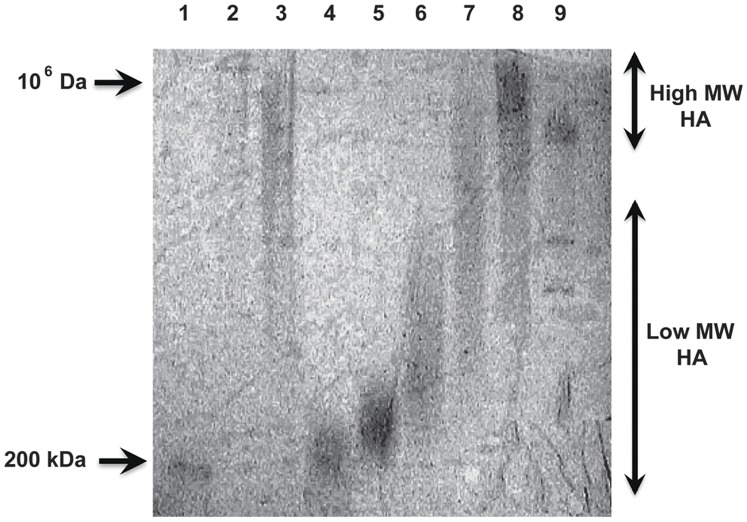
Fragmentation of HA by peroxynitrite and stimulation of TNFα and IL1ß by oligomeric HA in vitro.HMW HA (Healon™, 1×106 Da, Lane 2) was exposed to 100 µM 3-morpholinosydnonimine (SIN-1), a compound that spontaneously releases NO and superoxide to generate peroxynitrite. Exposure of HMW HA to SIN-1 results in degradation to LMW HA (300–500 kDa, Lane 6). Exposure to SIN-1 in the presence of 600 mU/ml superoxide dismutase (SOD) partially protects this degradation (Lane 7). Exposure to 300 µM PAPANOATE, a pure NO donor, does not degrade Healon™ (Lane 8). In addition, treatment of Healon™ with either 1 U/ml Streptomyces hyaluronidase at 60°C for 2 hours (Lane 4) or sonication for 2 minutes (Lane 5) results in formation of LMW HA. Just heating HMW HA at 60°C in the absence of hyaluronidase did not degrade HA in the same manner as in the presence of enzyme (Lane 2). Lane 1 has 200 kDa HA (ICN) and Lane 9 contains Hind III digested DNA makers.